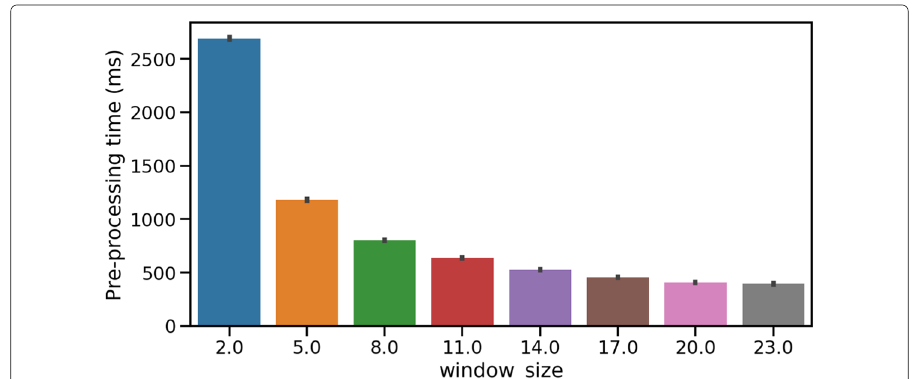
Fig. 13 Pre-processing and feature engineering time for each window size. This time corresponds to the time taken to create the transaction sequence, the graphs and the histograms